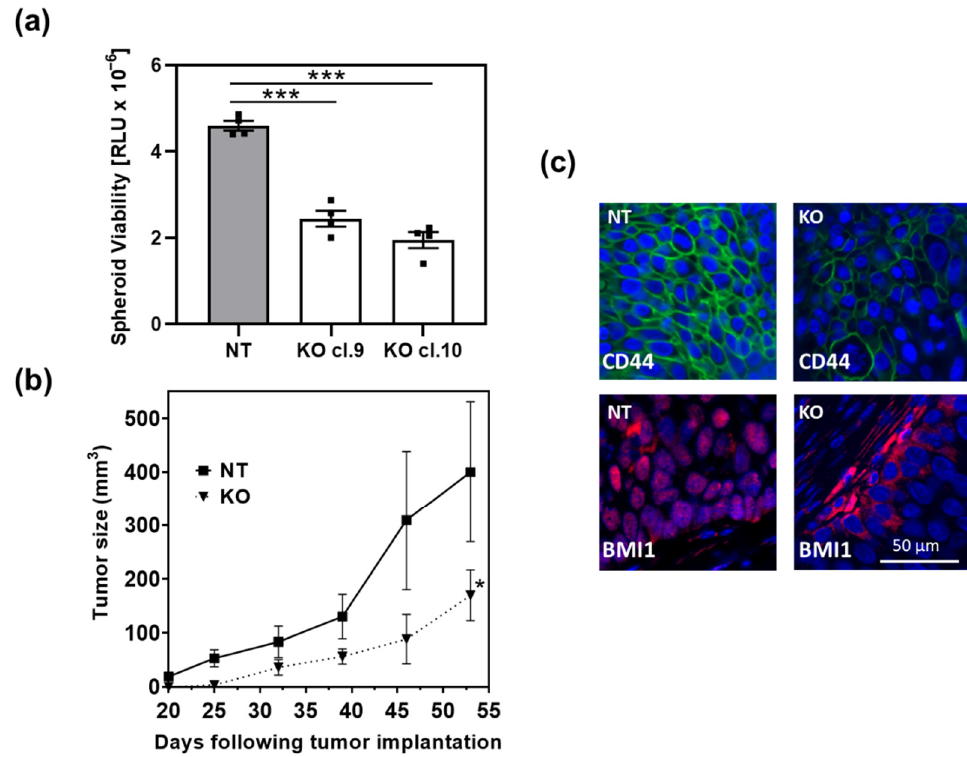
Figure 1. ARRB1 depletion affects spheroid formation and tumor growth: ARRB1 KO clones were established using the CRISPR/Cas9 technology as described previously [19]. ( a ) ARRB1-depleted HT1376 cells (KO cl.9 and KO cl. 10) and corresponding ARRB1 wild type controls (NT) were seeded at 2000 cells/well in 96-well plates for spheroid formation. Cells were placed on SeedEZ scaffolds to prevent attachment on plates and to allow spheroid formation as described in Material and Methods. The Cell Titer-Glo 3D Cell Viability assay was utilized to determine spheroid viability. Data: means ± SEM, n = 4; *** p < 0.001 (one-way ANOVA). ( b ) 1 × 10 6 ARRB1-depleted HT1376 cells (KO cl.10) ( n = 6) and corresponding controls (NT) ( n = 6) were transplanted subcutaneously in nude mice. Tumor growth was monitored weekly. Data: means ± SEM; * p = 0.0459 (two-way ANOVA). ( c ) Detection of CSC markers Bmi-1 and CD44 in ARRB1-KO HT1376 tumor